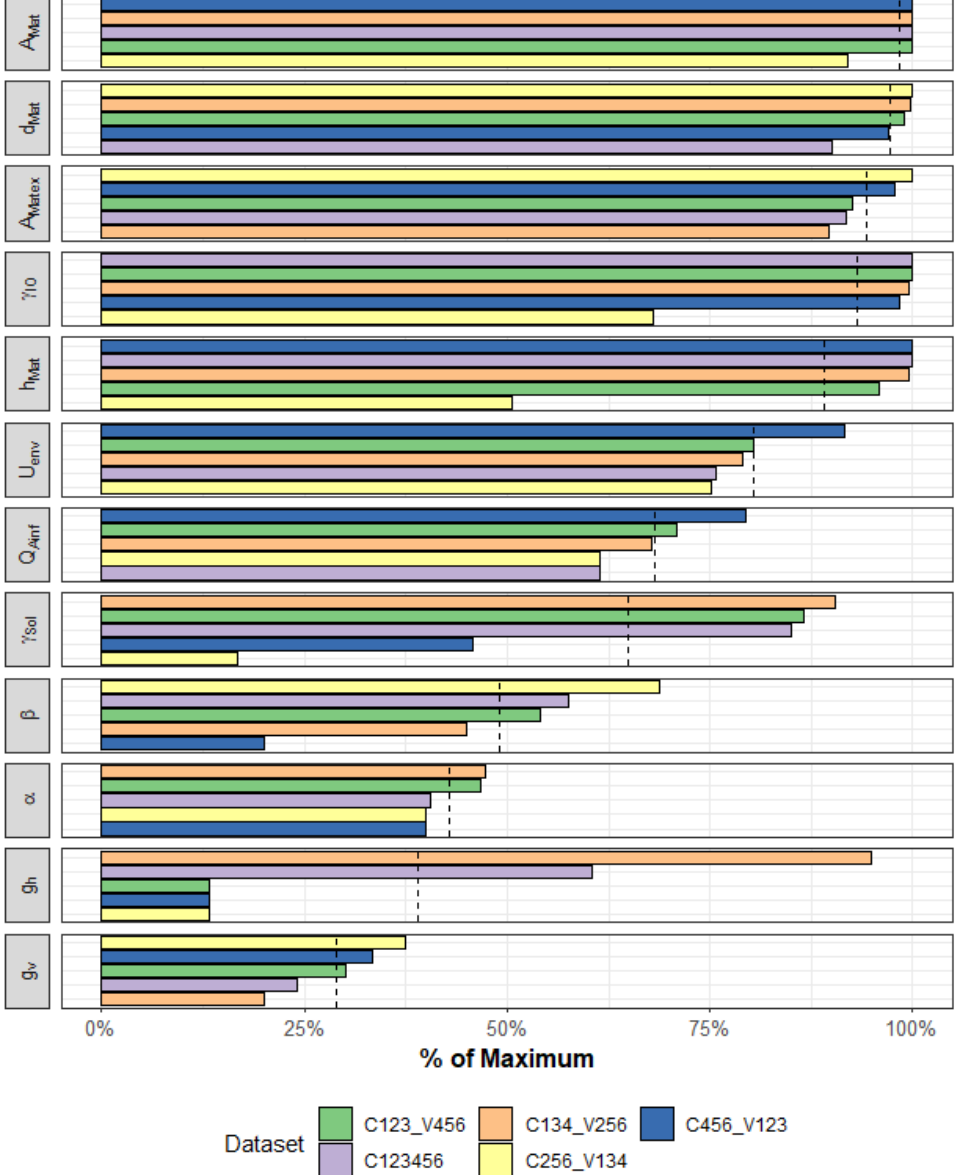
Figure 7. Parameter selecting based on GB models that were calibrated using three-week datasets (C3V3). Coloured bars indicate parameters selected for each calibration set, dashed line indicates mean value. Calibration is also indicated (C123456).